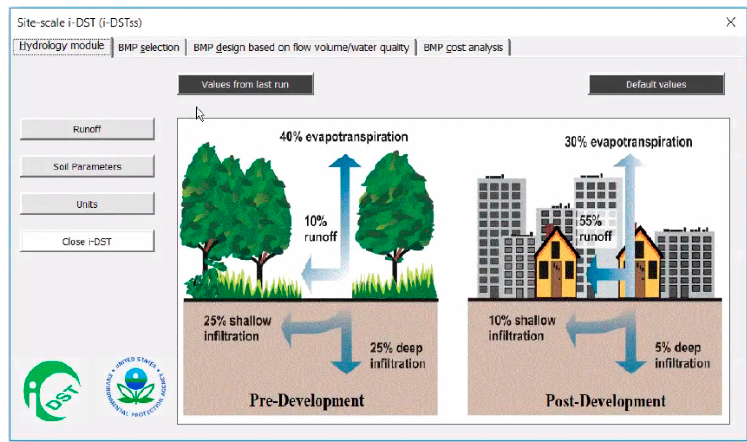
Figure A3. i-DSTss Graphical User Interface (GUI)